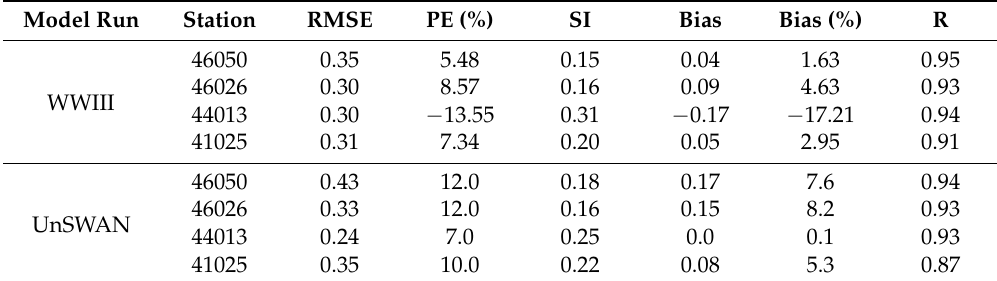
Table 3. Performance metrics for the WWIII and UnSWAN models.